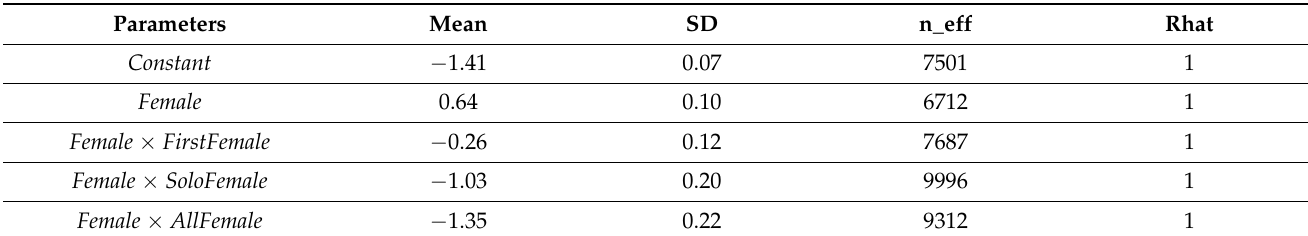
Table 2. Simulated posteriors.